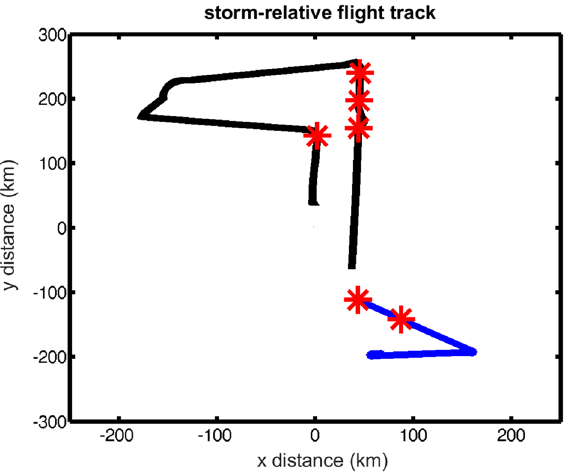
Figure 3. Legs of roll cases (red stars) during the flights in Nida (black) and Kalmaegi (blue). The flight tracks are plotted in a storm-relative framework with (0, 0) representing the storm